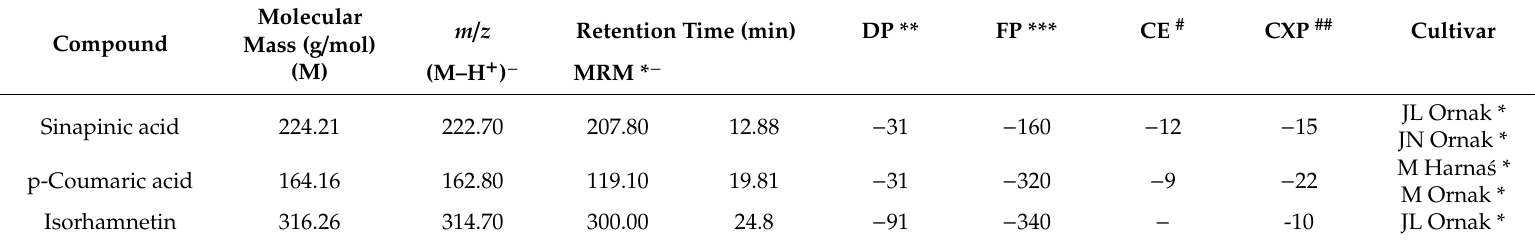
Table 3. Mass spectrometry parameters for phenolic compounds identified in whole plants of garlic cultivated from air bulbils.